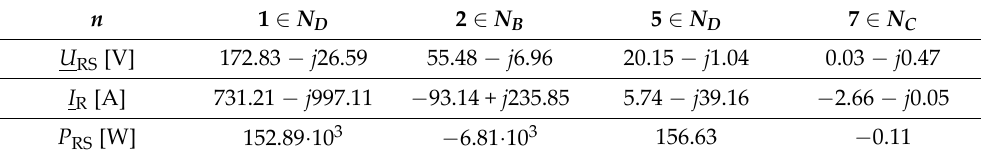
Table 2. Voltages, currents and